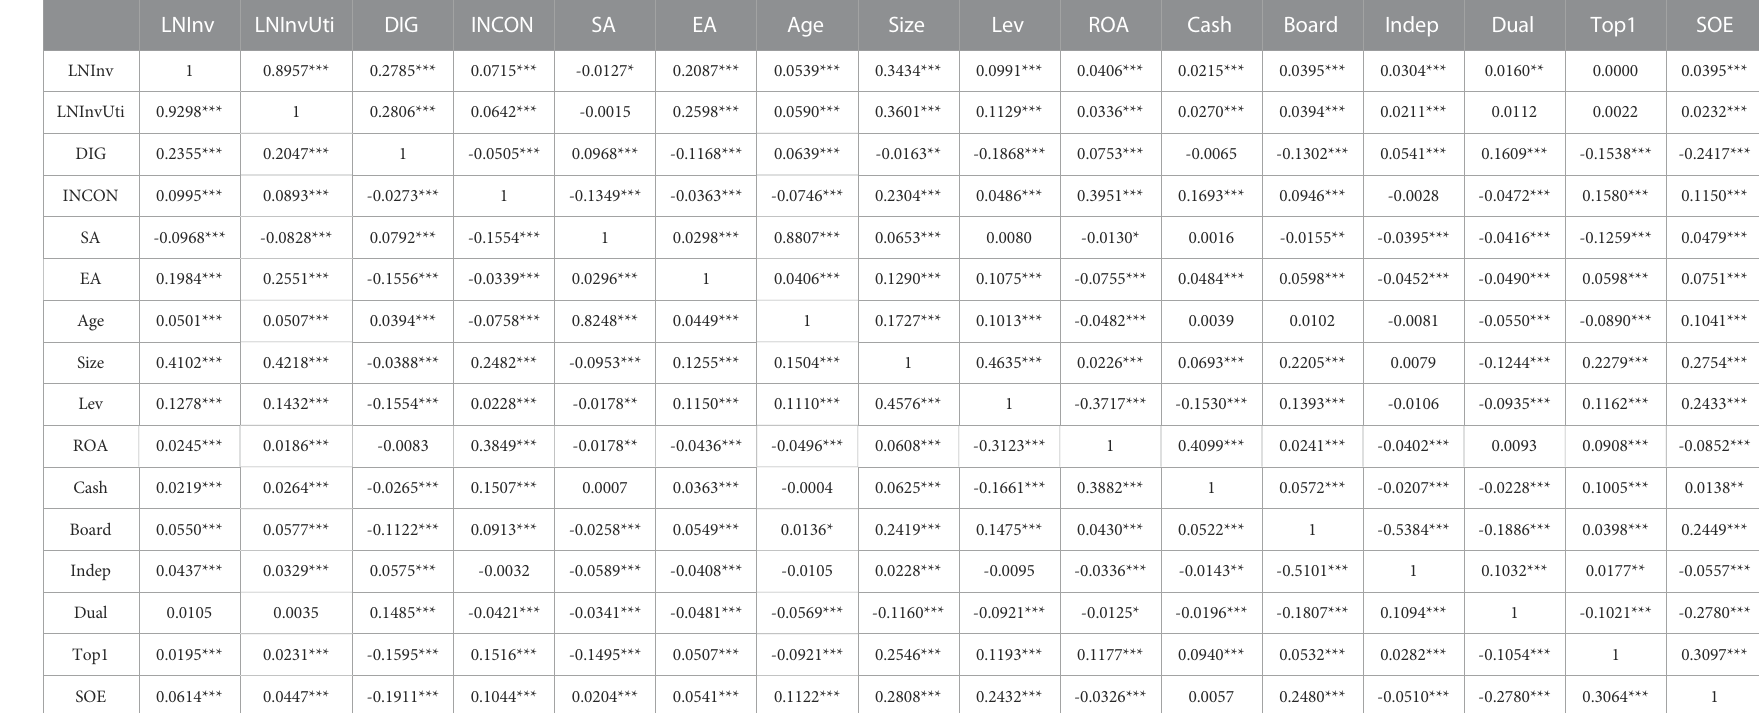
TABLE 2 Correlation